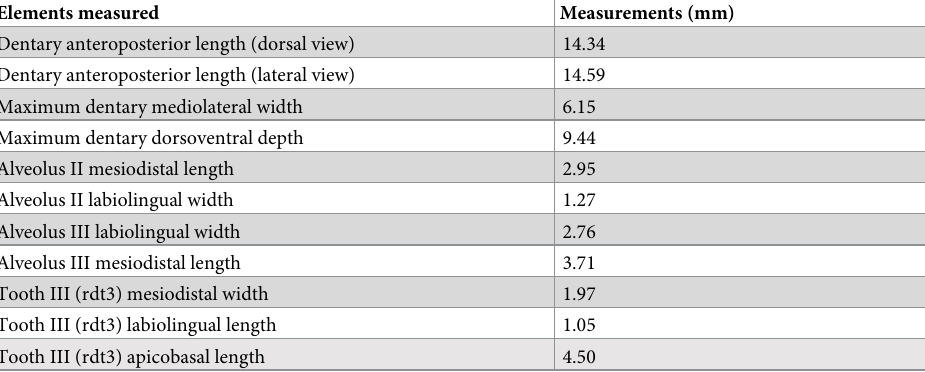
Table 1. Measurements of DMNH